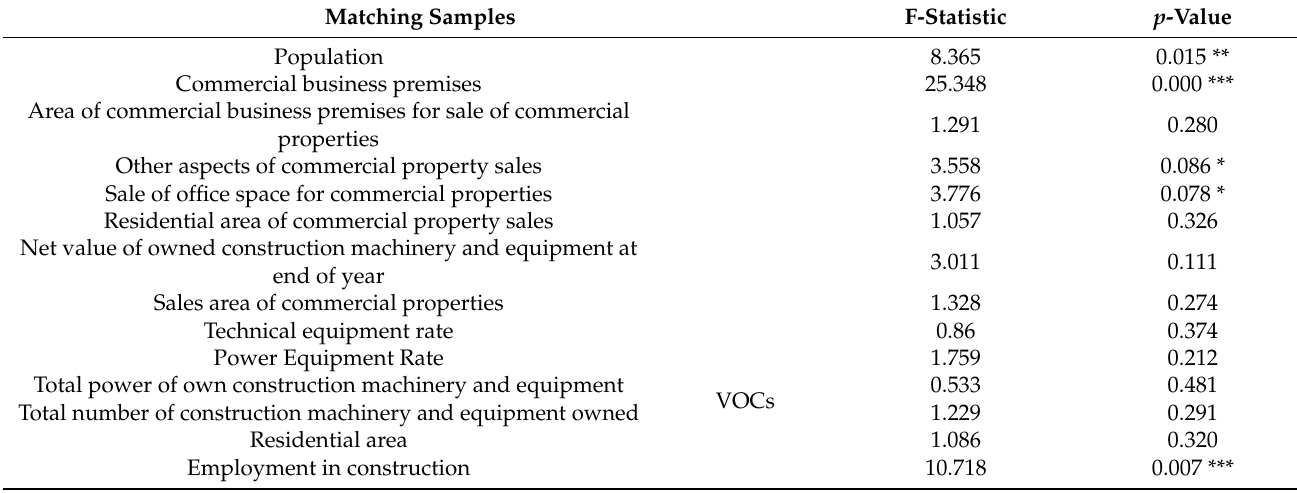
Table 3. Results of Granger’s causality test (***, **, * represent 1%, 5%, 10% level of significance re-